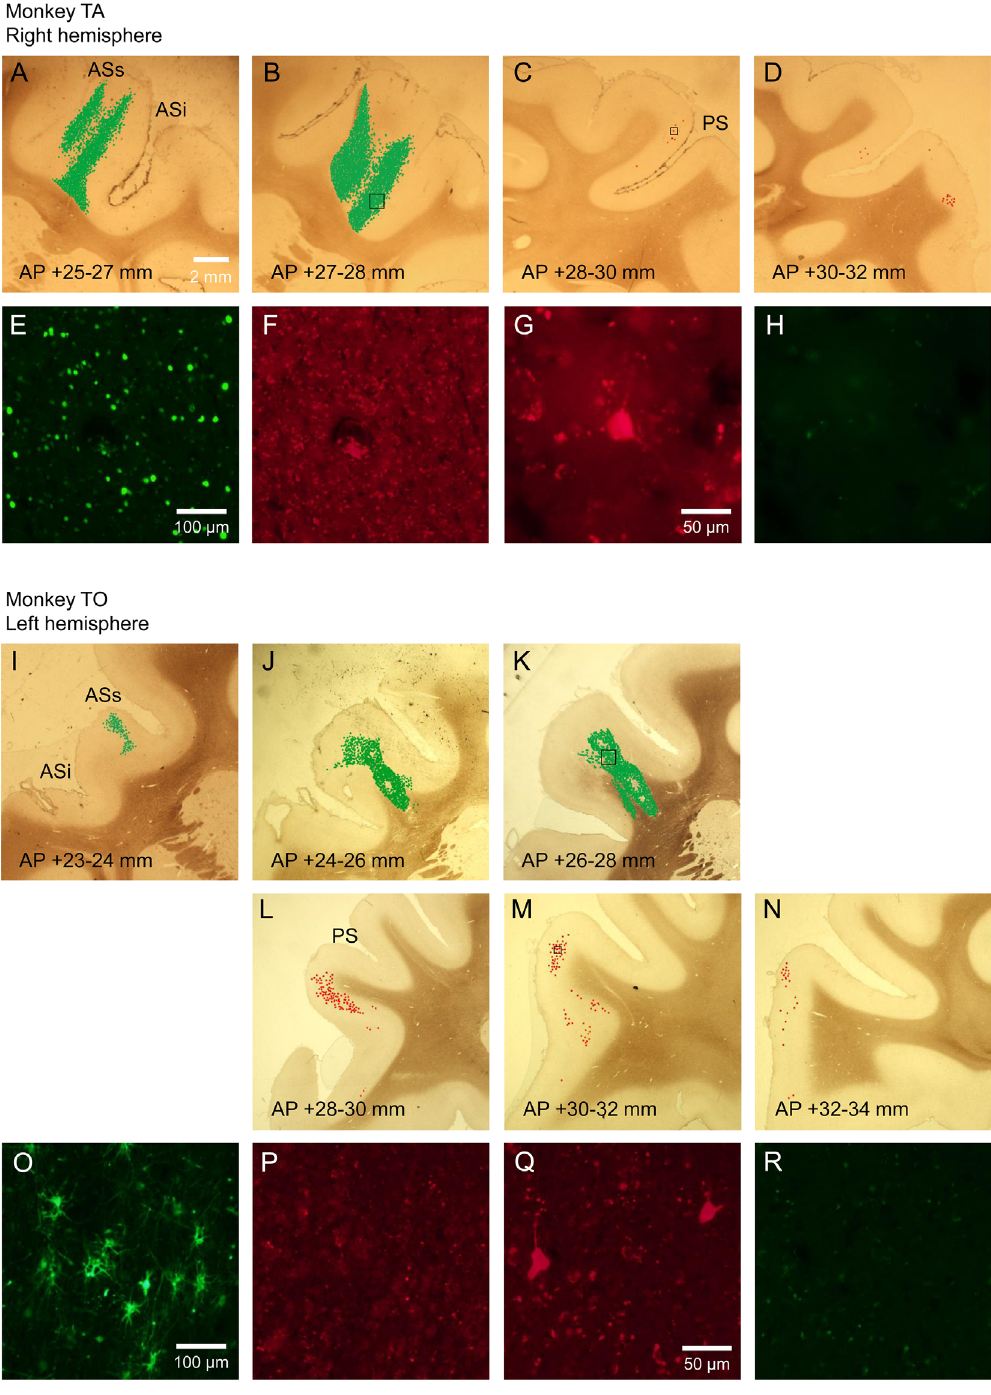
Fig 5. mCherry and eGFP expressions in the departure and the destination areas of the frontofrontal pathways. (A-D). Distribution of mCherry- and eGFP-positive cells in the right FEF and the ipsilateral LPFC of Monkey TA. (E). eGFP-expressing cells in the boxed area of figure B as observed with a NIBA filter cube. (F) The micrograph of the same area as (E) as observed with a WIG filter cube. (G). A mCherry-expressing cell in the boxed area of figure C as observed with a WIG filter cube. (H) The micrograph of the same area as (G) as observed with a NIBA filter cube. (I-N). Distribution of mCherry- and eGFP- positive cells in the left FEF and the ipsilateral LPFC of Monkey TO. (O). eGFP-expressing cells in the boxed area of figure K as observed with a NIBA filter cube. (P) The micrograph of the same area as (O) as observed with a WIG filter cube. (Q). mCherry-expressing cells in the boxed area of figure M as observed with a NIBA filter cube. (R) The micrograph of the same area as (Q) as observed with a NIBA filter cube. ASs: The superior ramus of the arcuate sulcus, ASi: The inferior ramus of the arcuate sulcus, PS: The principal sulcus.